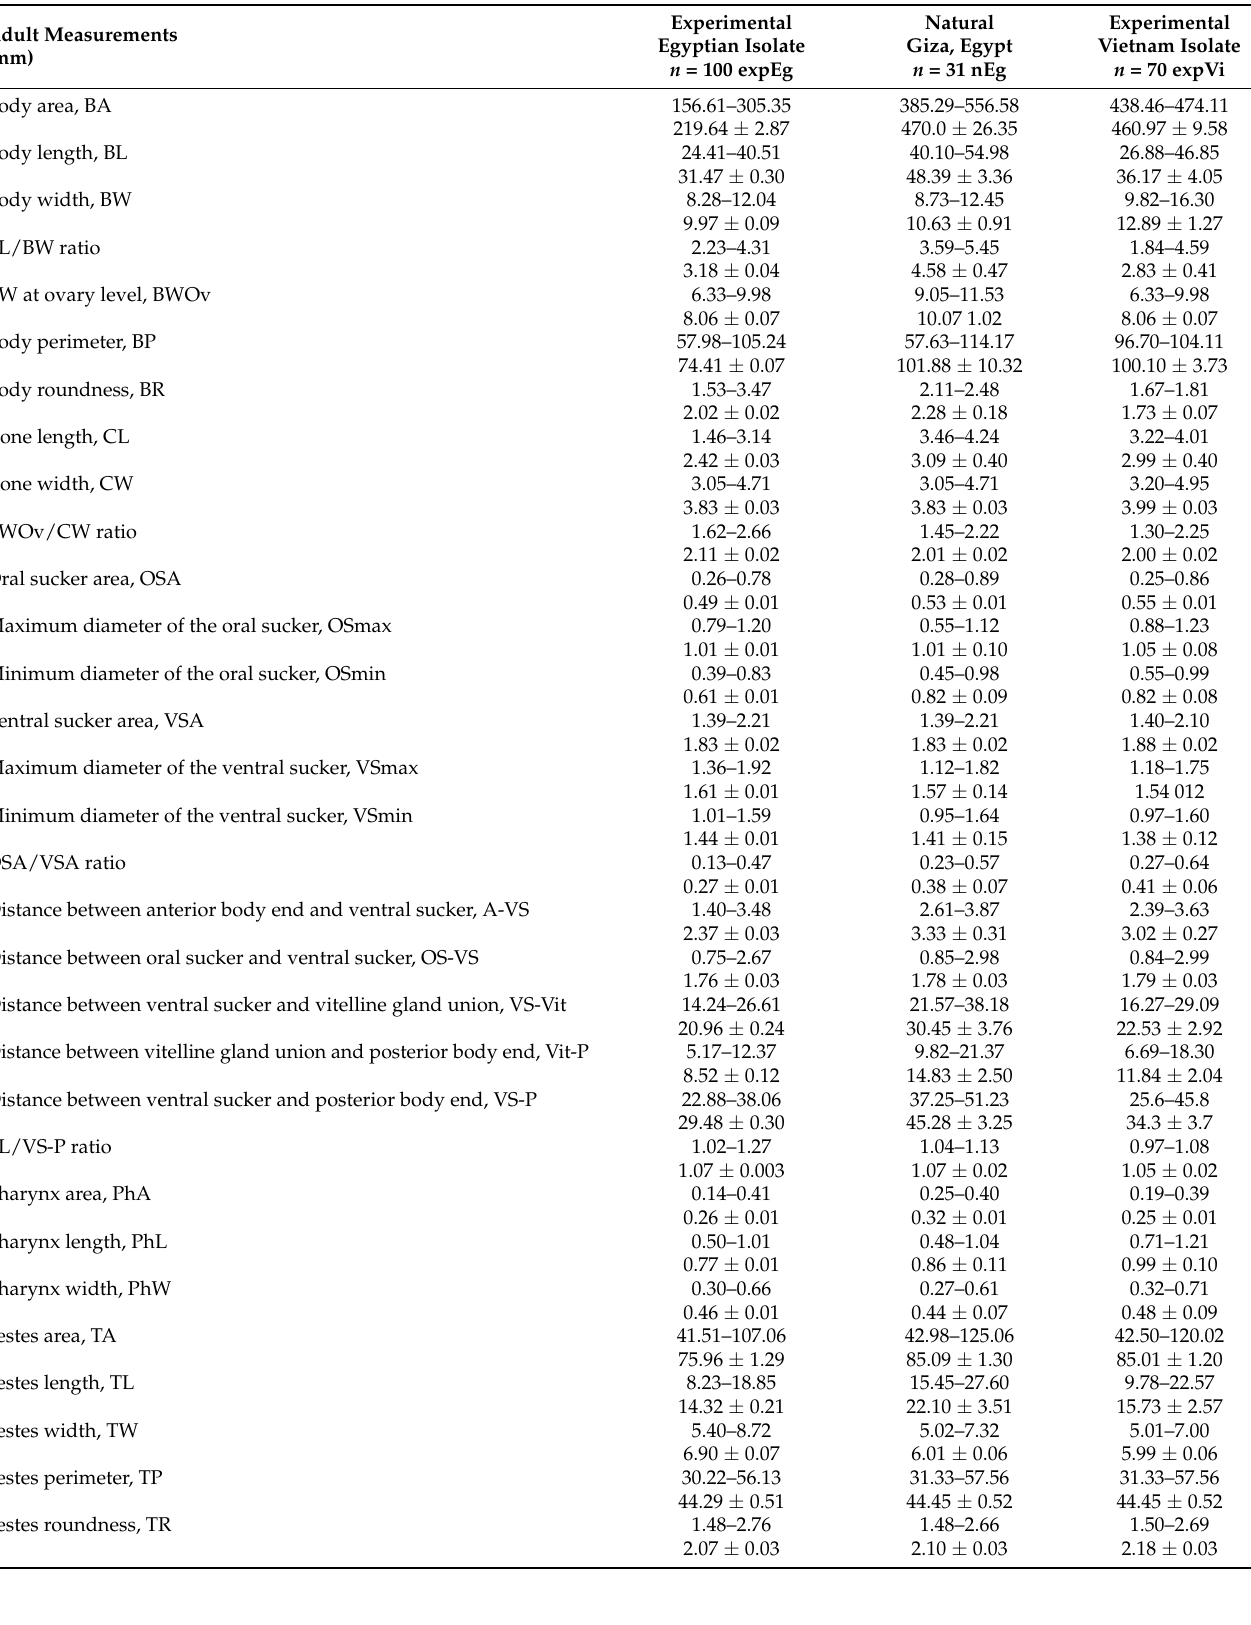
Table 3. Comparative morphometric data (extreme values, mean and standard deviation) of natural and experimental liver flukes of Fasciola gigantica from lowland sheep ( n = number of